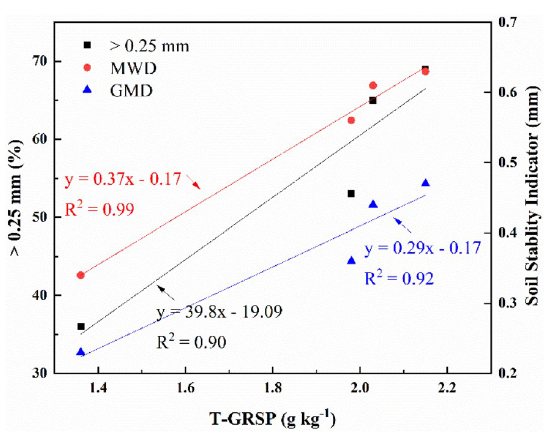
Figure 3. Correlations between the glomalin-related soil protein (GRSP) and aggregate stability indicators during 10-year